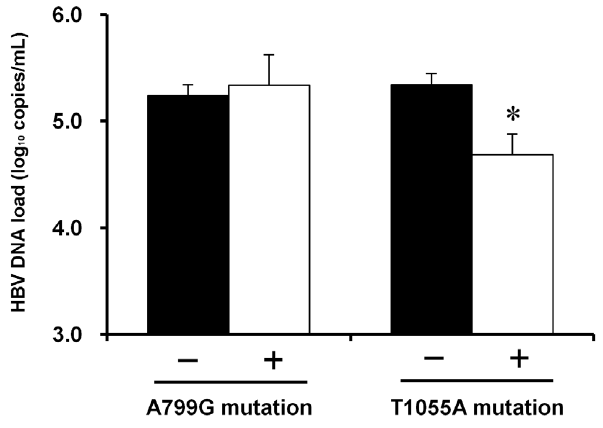
Figure 3. Effects of the A799G and T1055A mutations on circulating HBV DNA levels in all participants. The effects of the mutations A799G and T1055A on circulating HBV DNA load were estimated using blood samples from a total of 468 participants (HCC patients or non-HCC controls). Among these participants, 47 (10.0%) harbored A799G and 48 (10.3%) harbored T1055A. Circulating hepatitis B virus (HBV) DNA level was determined by quantitative real-time PCR. The data represent the mean 6 SE. *, P ,